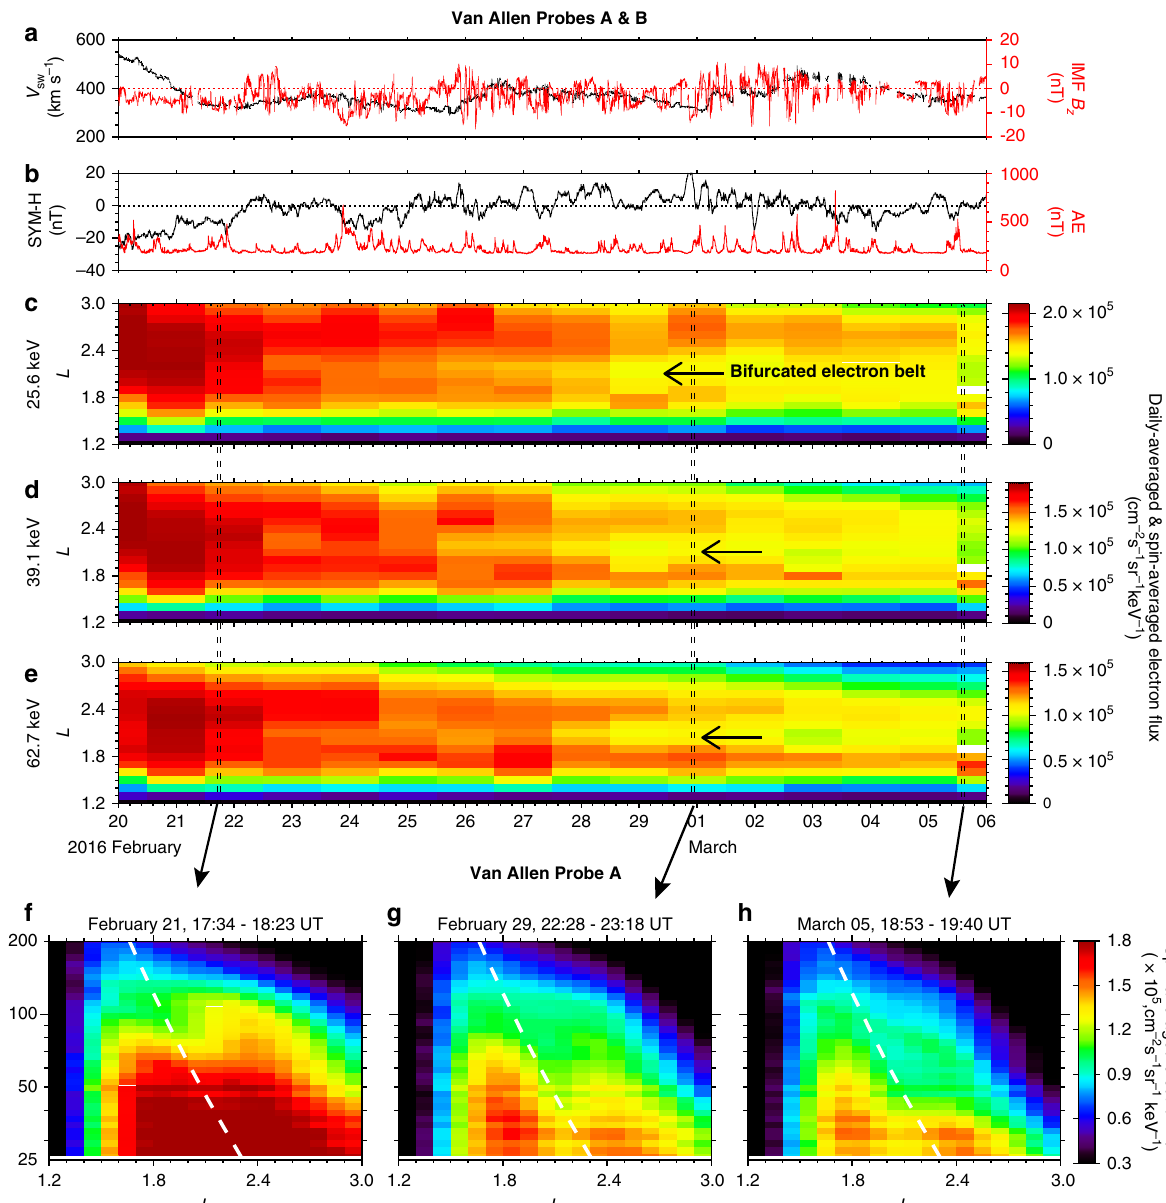
Fig. 1 Radial pro fi les of energetic electron fl uxes from 20 February to 06 March 2016. a Solar wind speed ( V sw ) and north-south component of the interplanetary magnetic fi eld (IMF B z ) in Geocentric Solar Magnetospheric (GSM) coordinates (where x -axis points from the Earth to the Sun and the z -axis is the projection of the Earth ’ s dipole axis onto the plane perpendicular to the x axis). b Sym-H index (black), which describes the disturbance of the horizontal geomagnetic fi eld component near the equator, and geomagnetic auroral electrojet (AE) index (red), which measures the disturbance of the horizontal component of the geomagnetic fi eld around the auroral oval. c – e Daily- and spin-averaged electron fl uxes measured by RBSPICE from both Van Allen Probes at 25.6, 39.1, and 62.7 keV, respectively. f – h Radial pro fi les of spin-averaged electron fl ux during three indicated outbound trajectories of Van Allen Probe A, where the white dashed curves indicate the minimum fi rst-order cyclotron resonant energies of electrons interacting with 24 kHz VLF transmitter waves at the geomagnetic equator (see more details in the section of “ Calculation of electron cyclotron resonant energy ” in “ Methods ”